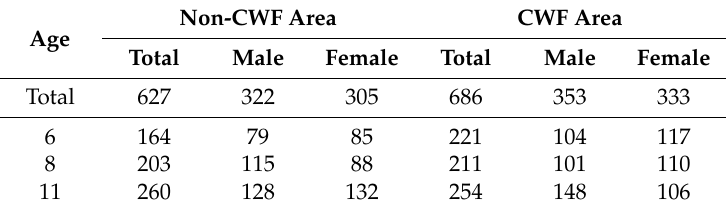
Table 1. Number of participants in areas with and without community water fluoridation